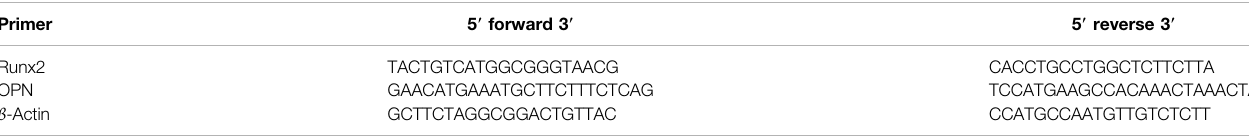
TABLE 1 | Primers for qRT-PCR analysis of gene expression.